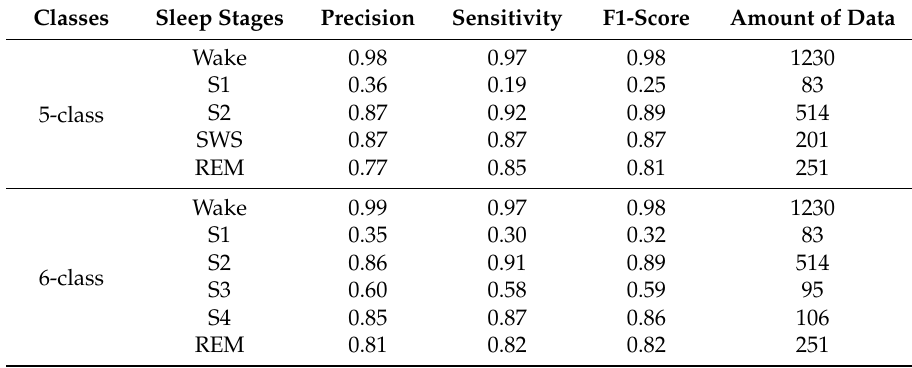
Table 7. The performance values obtained for the five-class and six-class test data using the sleep-edf dataset with a single-channel EEG signal. SWS: slow-wave sleep.